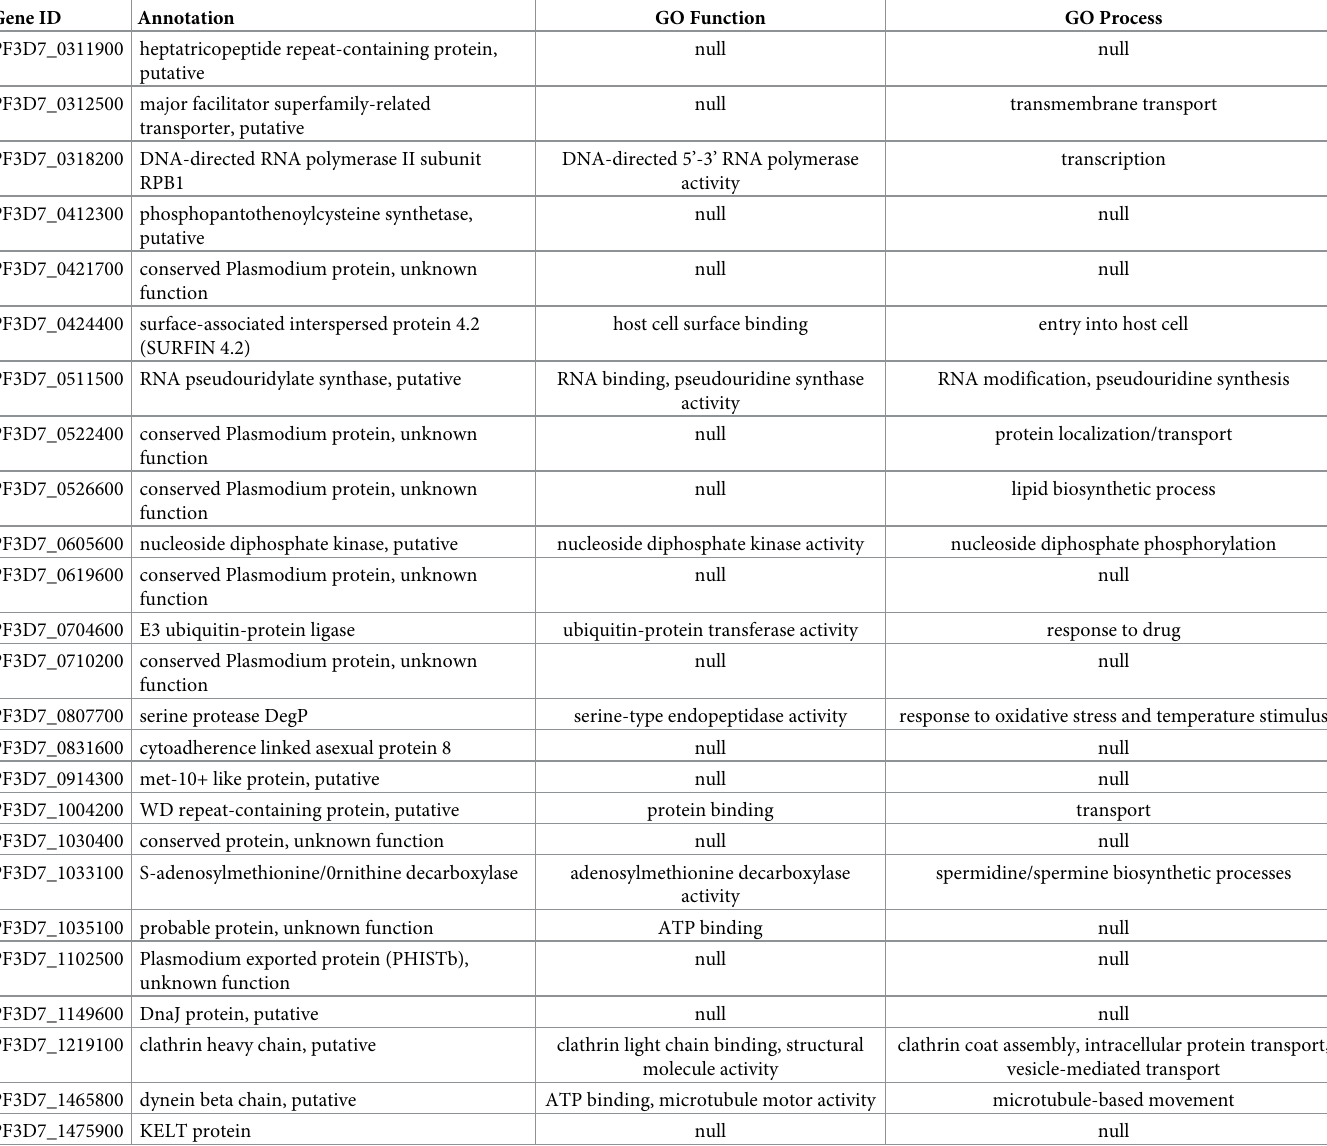
Table 2. Gene products identified as likely targets of allele-specific immunity to malaria based on two analytical